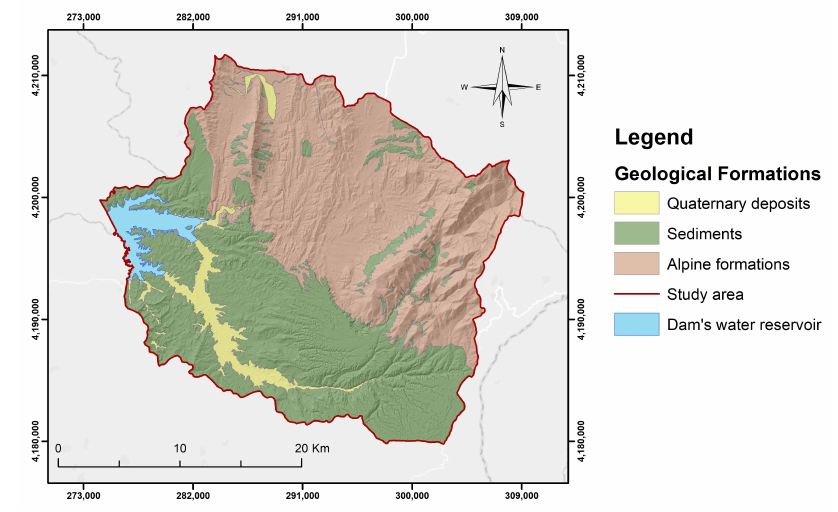
Figure 4. The geological formations of the research